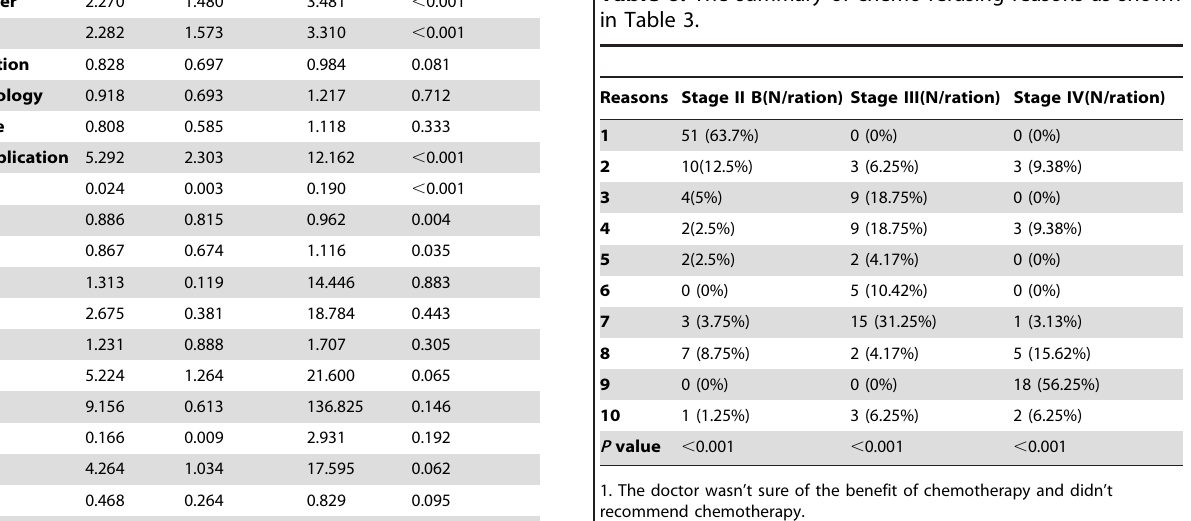
Table 6. The summary of chemo-refusing reasons as shown in Table